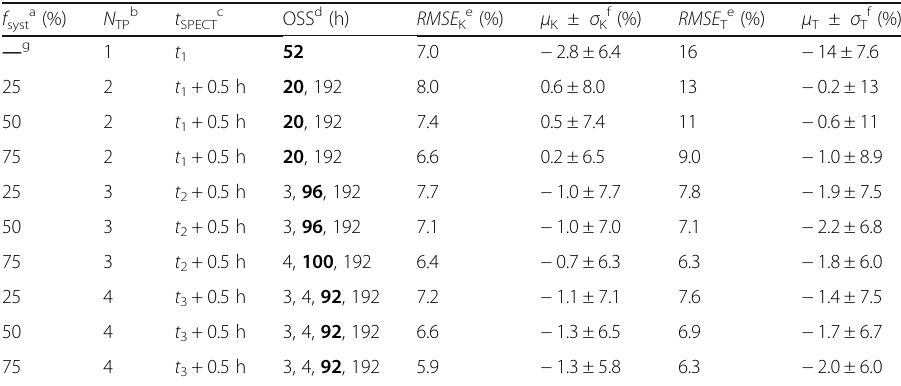
Table 1 OSS for joint kidney and tumour dosimetry based on the hybrid planar/SPECT method and on the approximation by Hänscheid et al. [13] (Eq.